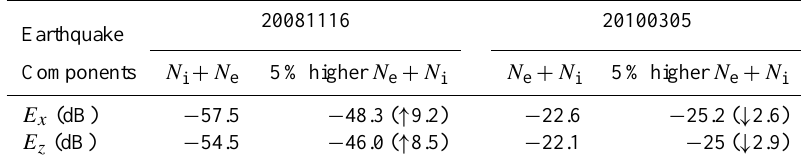
Table 3. Simulation result of E x and E z (660km) at 10Hz during earthquake and before earthquakes.